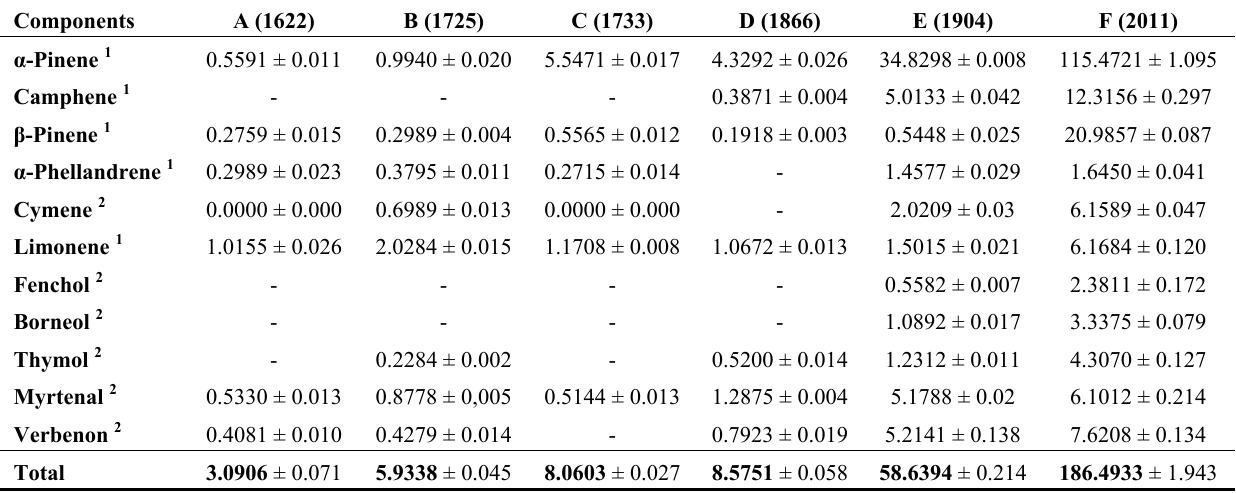
Table 1. Quantities of terpenes in samples of non-treated wood